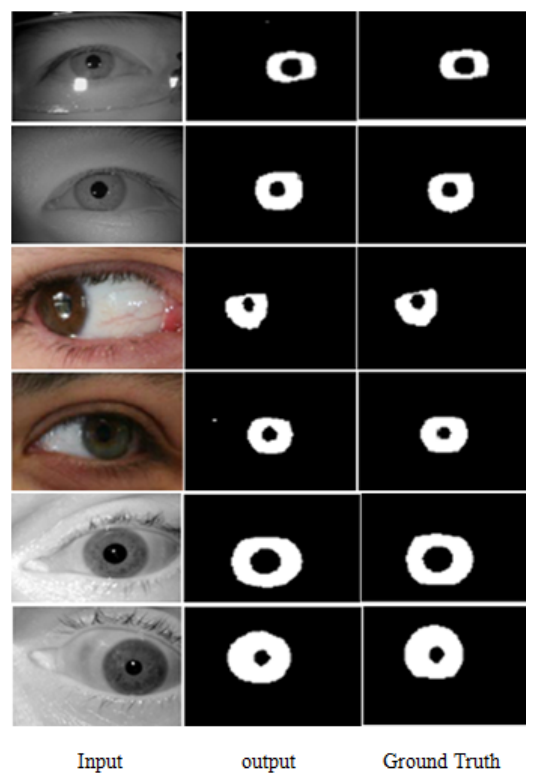
Figure 2. Segmentation results by FCNs. The two first, two second and Two third rows are the three database: CASIA-Iris-Thousand, UBIRIS.v2 and LG2200, respectively. The first, second and third columns are the input images, output of our results and the ground truth,